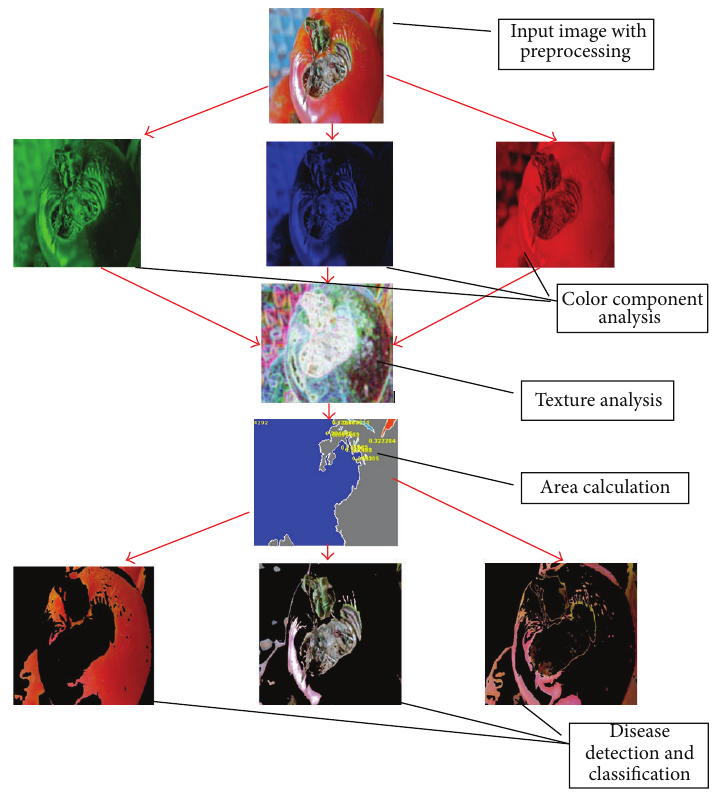
Figure 8: Flow diagram of extracted results for tomato